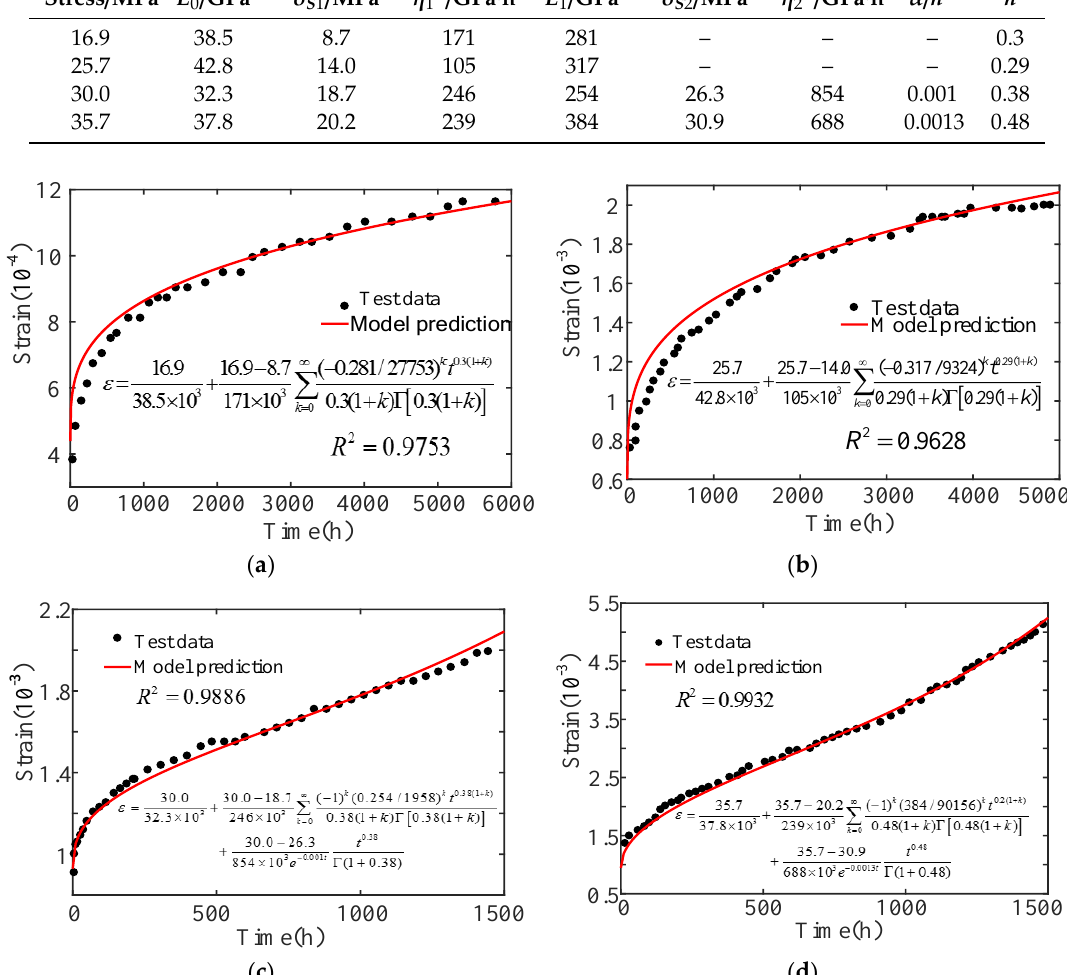
Table 2. Parameter table of concrete creep model.